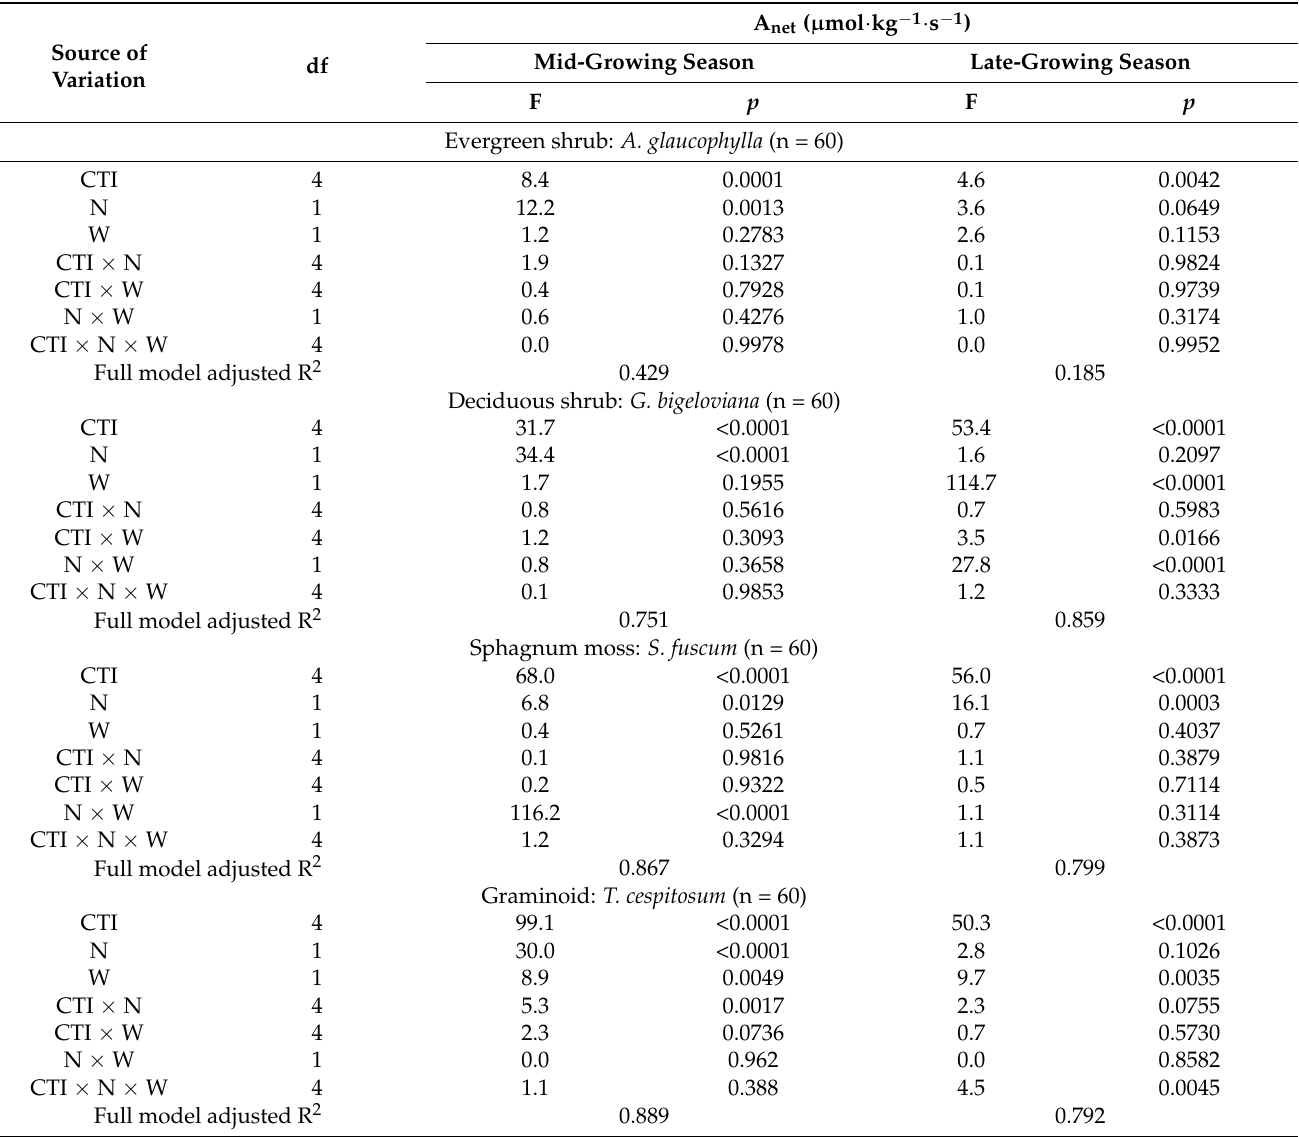
Table 2. Summary of models of both CO 2 and temperature increments (CTI), warming treatment (W), and N fertilizer addition (N), and their combined effects on foliar net photosynthesis (A net ) in four dominant plant species during the mid and late-growing seasons at a boreal bog.